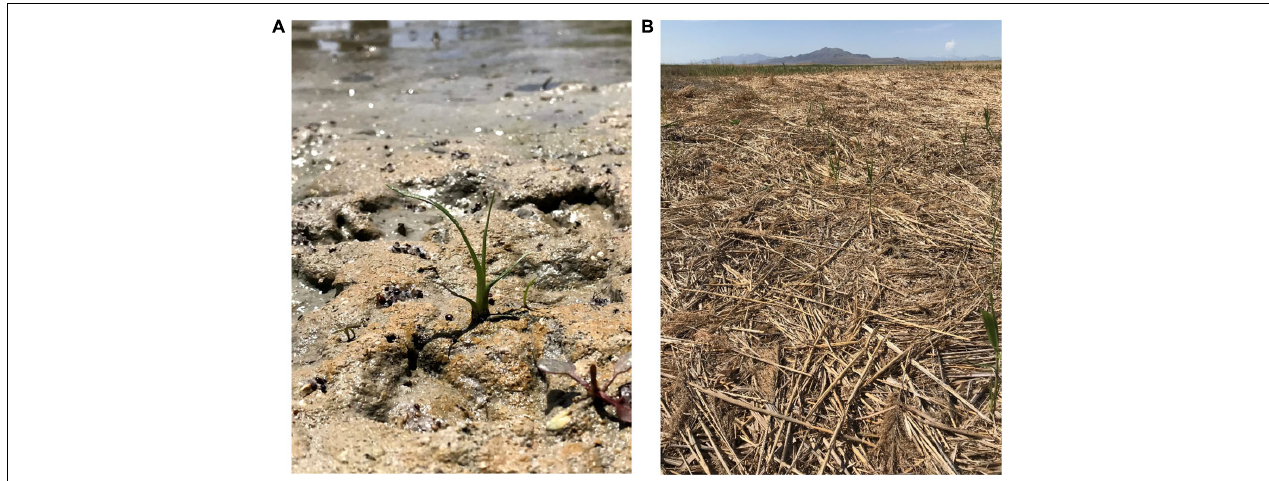
FIGURE 6 | (A) An example of a safe site, in this case for cattail ( Typha L. spp.) seed germination, which includes high light and moist soils. (B) Through appropriate site preparation, it is important to address constraints to seeds and seedlings such as unwanted legacy effects. Here, a thick litter layer remains after invasive Phragmites control treatments. This legacy effect likely limits native seed germination and managers need to utilize techniques to remove this litter prior to hydroseeding.